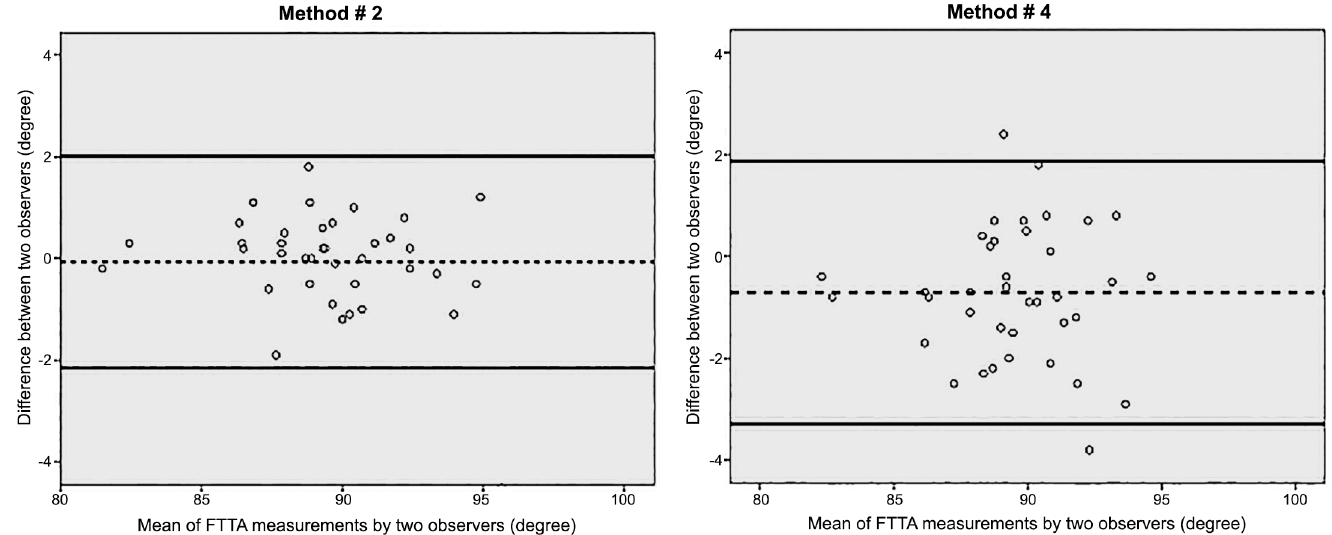
Fig 5. Bland Altman Plots. Bland and Altman plots depicting the FTTA measurements of method 2 and 4, demonstrating better agreement with use of method 2 (left) compared with use of method 4 (right). The average of the measurements made by two observers is plotted against the difference between the measurements made by those two observers. The dashed lines represent the mean value of all differences between the two observers, and the dotted lines represent the 95% limits of